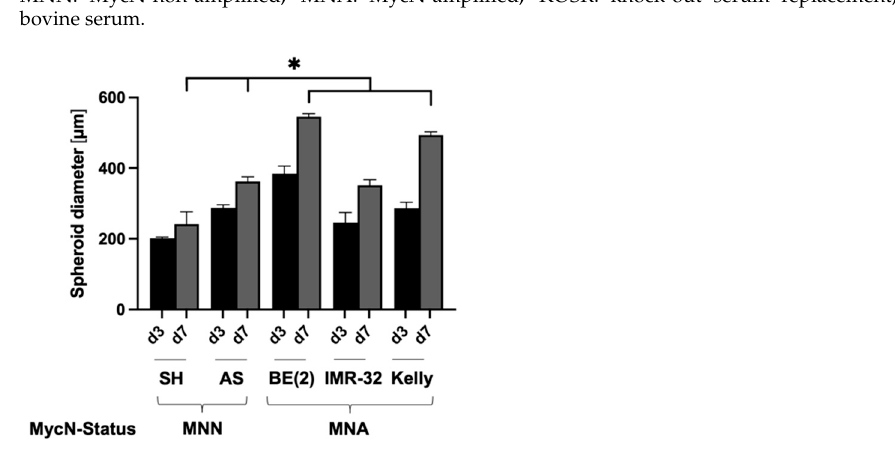
Figure 2. Size of spheroids of five different neuroblastoma cell lines grown in 3D culture. Diameter of spheroids from neuroblastoma cell lines SK-N-SH (SH), SK-N-AS (AS), SK-N-BE(2) (BE(2)), IMR-32 and Kelly grown under established conditions (Table 1) on 96-well ULA plates for 3 days (d3) or